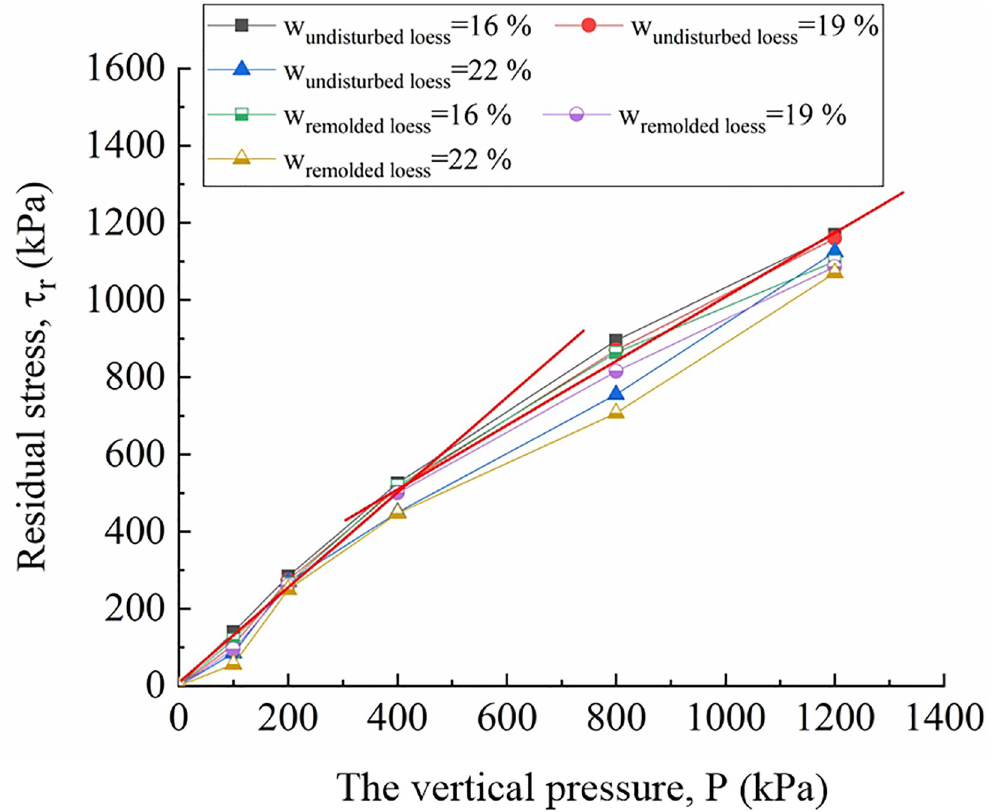
Fig 18. Residual strain- vertical pressure curve of 4 # - 18 # undisturbed and 22 # - 36 # remolded loess specimens.